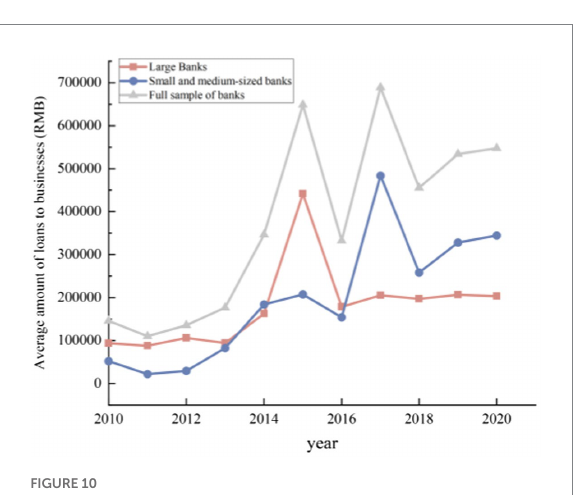
FIGURE 10 Average amount of bank lending to